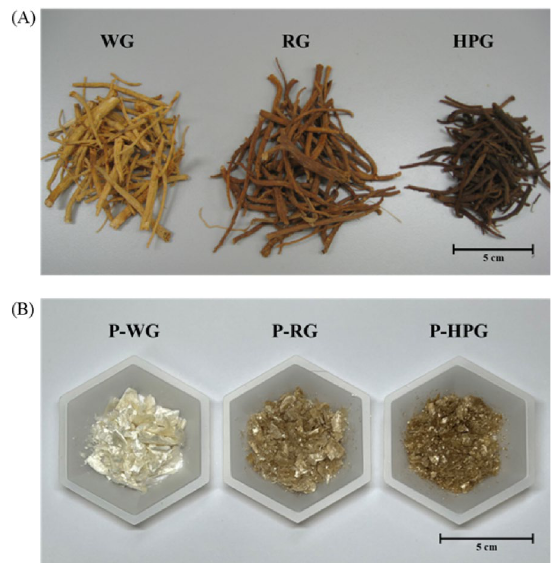
Fig. 1 Image of original ginseng materials ( a ) and their polysaccharide extracts ( b ). WG white ginseng, RG red ginseng;